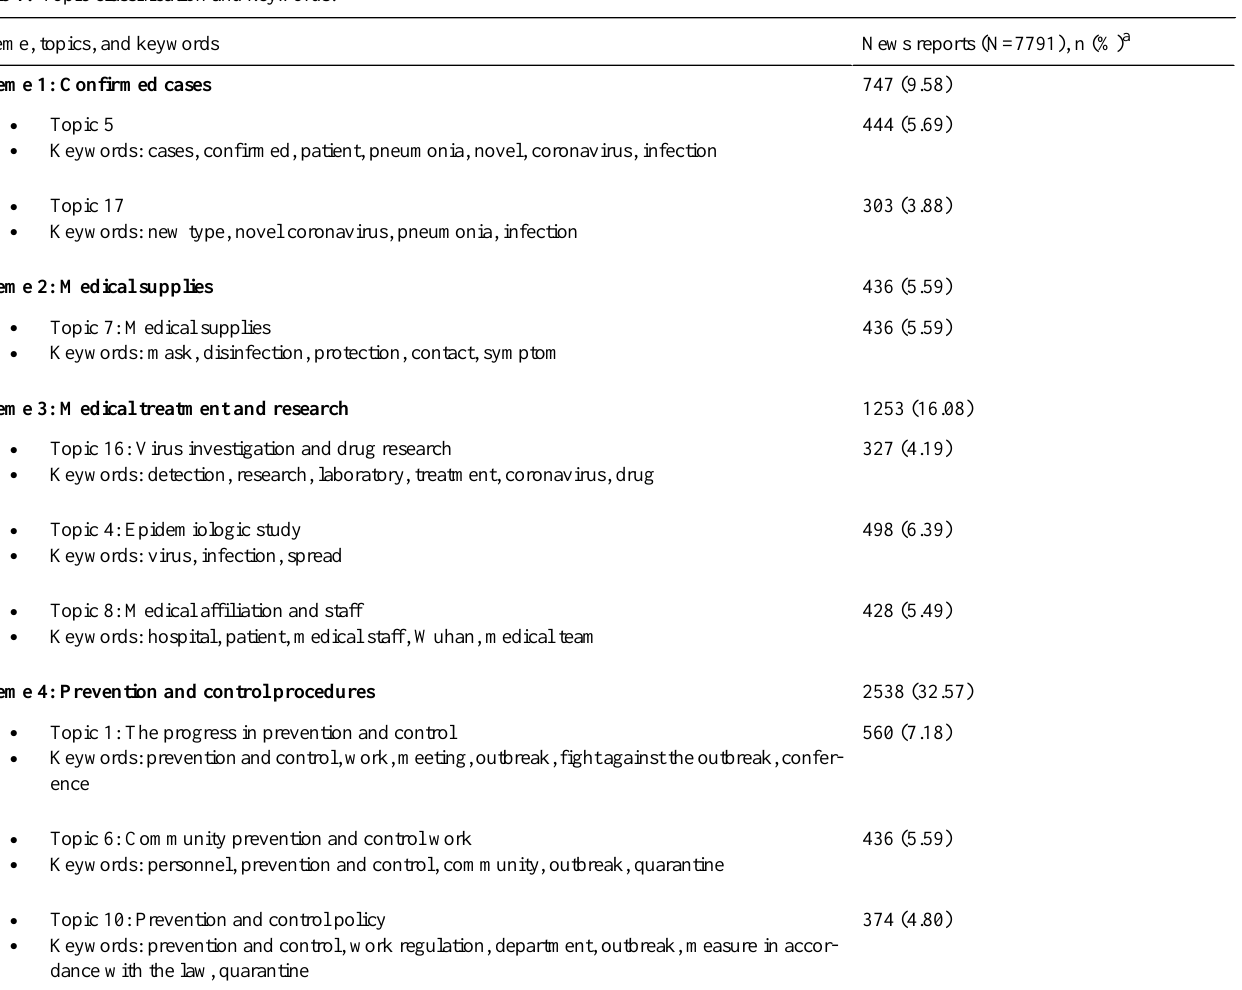
Table 1. Topic classification and